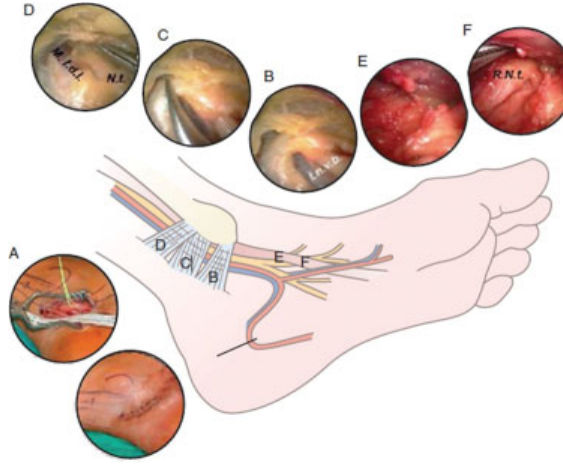
Fig. 6 Endoscopic tarsal tunnel release.